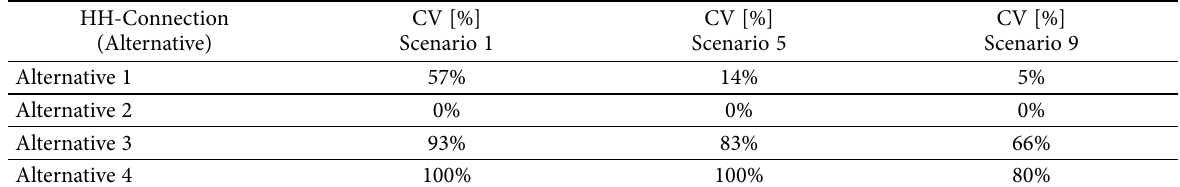
Table 12. Certainty value results from the reference scenario